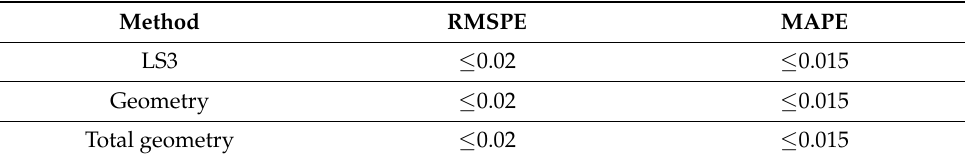
Table 2. Error Table 2. Error Calculation.